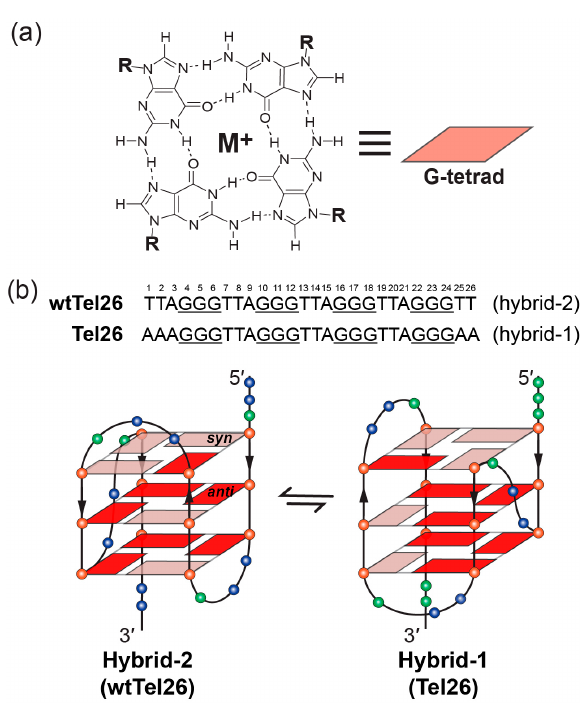
Figure 2. Schematic illustration of G-tetrad and the folding pattern of hybrid-2 and hybrid-1 telomeric G-quadruplexes. ( a ) Schematic representation of G-tetrad. Monovalent cations (M + ), such as K + or Na + , are required for the G-tetrad formation. ( b ) Human telomeric sequences predominantly fold into two hybrid-type G-quadruplexes with an equilibrium between hybrid-1 (PDB ID: 2HY9) and hybrid-2 (PDB ID: 2JPZ) forms. The human telomeric sequences used to determine hybrid-2 (wtTel26) and hybrid-1 (Tel26) structures are shown on the top. Strand polarities are indicated as the black arrows. Glycosidic conformations of guanine nucleotides are marked as follows: syn -pink and anti -red. Different nucleotides are represented as follows: Thymine, blue sphere; guanine, red sphere; and adenine, green sphere.